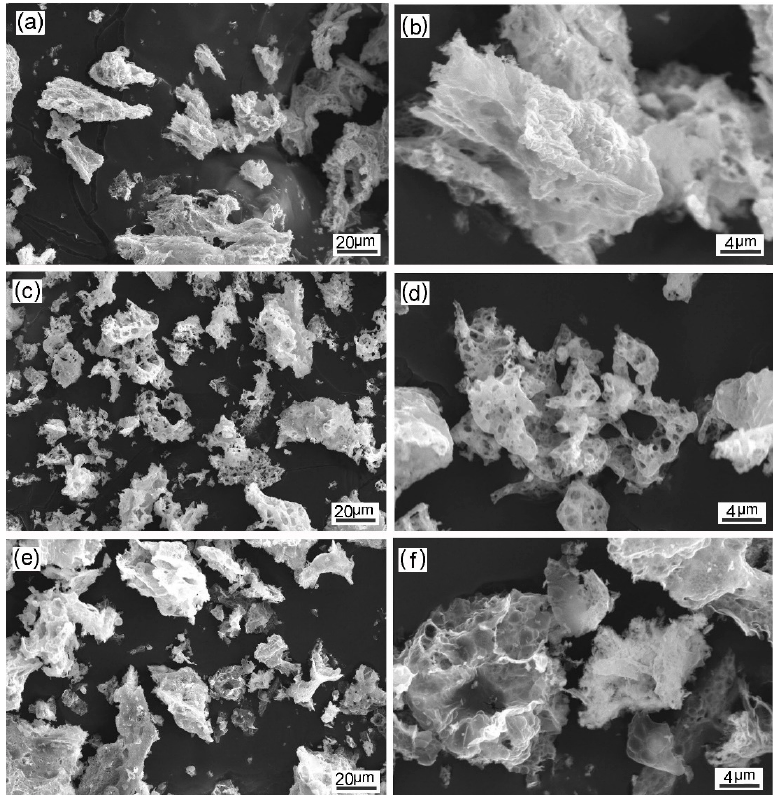
Figure 1. Secondary electron microscopy (SEM) images of the combusted powder made from the solution precursors with varied U/Co and C/Co molar ratios: ( a , b ) U/Co = 0.5, C/Co = 1.5; ( c , d ) U/Co = 1.2, C/Co = 1.5; ( e , f ) U/Co = 1.2; C/Co = 3.0.